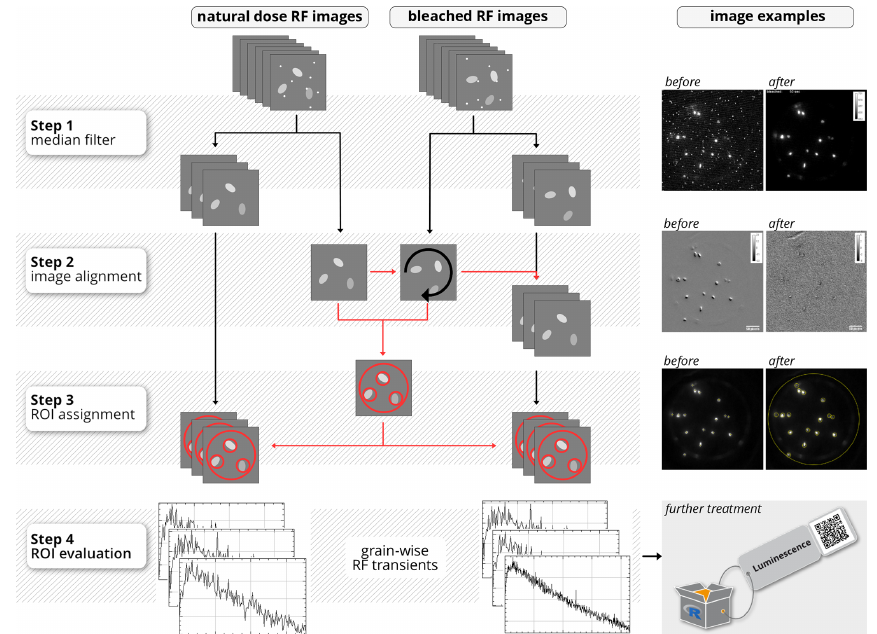
Figure 3. Image-processing workflow as performed by the ImageJ macro SR-RF.ijm . Note: the grey step 2 images show the signal value differences between the median signal values of the natural dose RF images and the median signal values of the regenerated dose RF images. A homogeneous colour means that the images are aligned. Table 4. Recommended SR-RF macro settings for the first image-processing run, depending on the sample brightness and the grain size. Parameter refinements depending on the system and the sample might be necessary. The two lower columns display the properties of the resulting single-grain IR-RF curves. The sample area diameter values assume a lateral magnification of 0.6 and a pixel size of 16µm. Macro parameter ∼ 50–80µm grain size ∼ 180–250µm grain size Bright sample at Dim sample at Bright sample at Dim sample at full resolution ∗ high SNR setting ∗ full resolution ∗ high SNR setting ∗ Image group size 5 5 5 5 Noise tolerance 15 10 15 10 ROI diameter 5 3 12 7 Time resolution of single-grain IR-RF curve 25s 25s 25s 25s Diameter of sample area covered by ROI 133µm 160µm 324µm